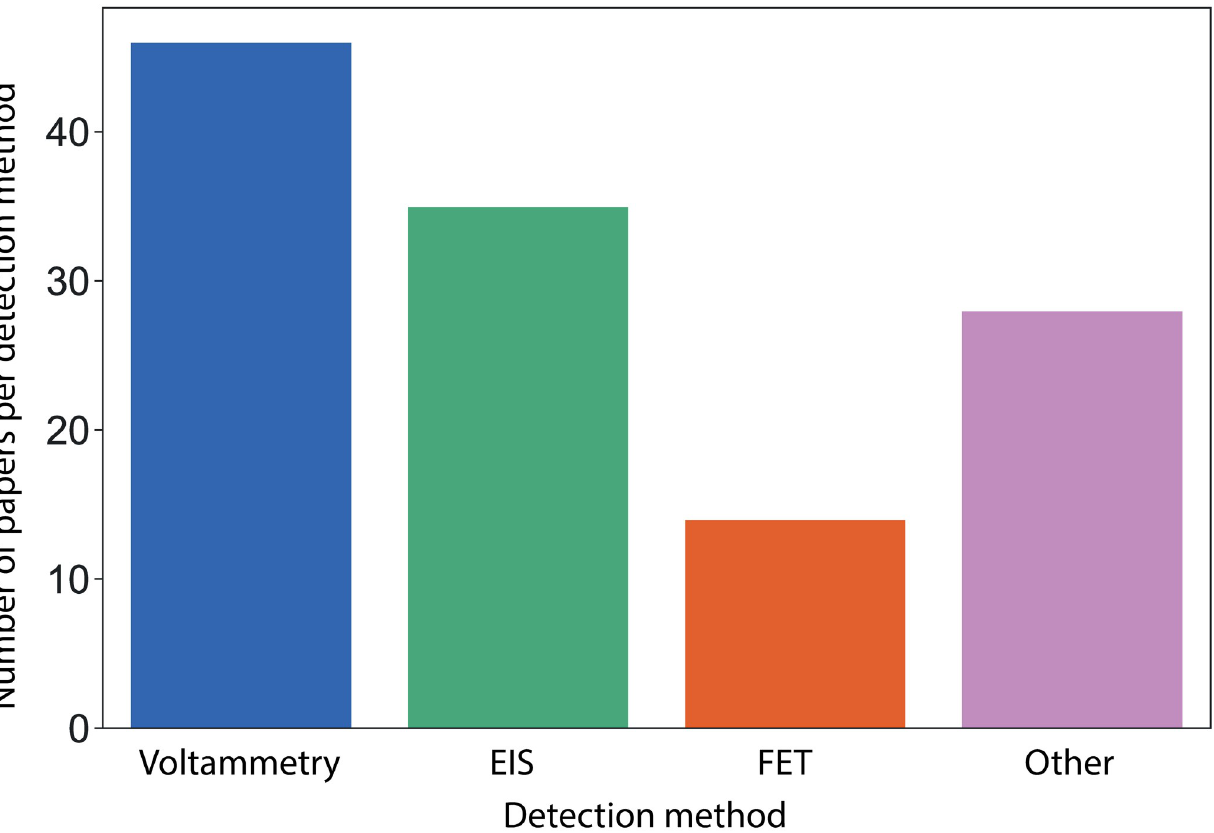
Fig 2. Number of papers selected for this review divided by detection method. Voltammetry (blue), EIS (green), FET (orange), other (purple). EIS: Electrochemical Impedance Spectroscopy, FET: Field Effect Transistor.